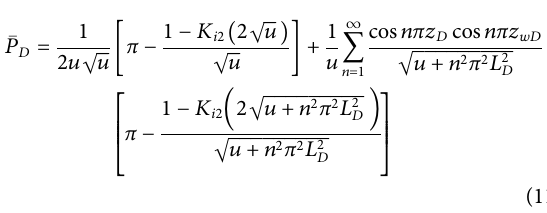
Formation pressure distribution plan near volume fracturing horizontal